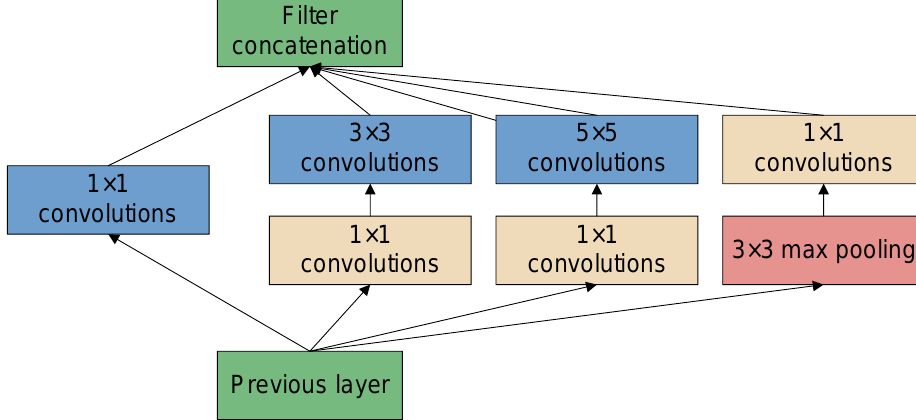
Figure 6. Structure diagram of the Inception module.